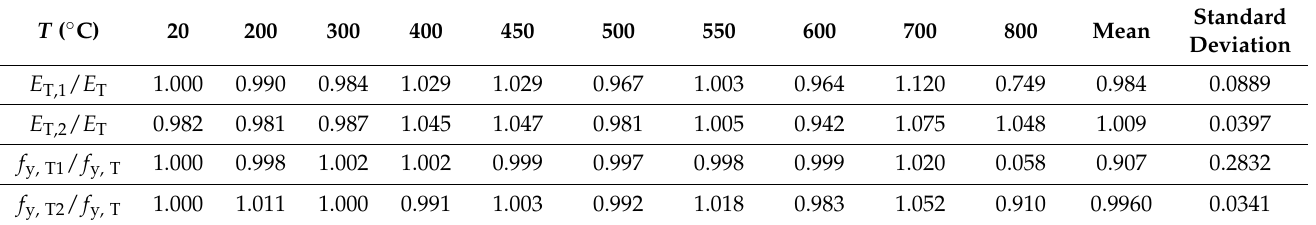
Table 4. Comparison of predicted results between Huang’s and present formulations for E T and f y, T .